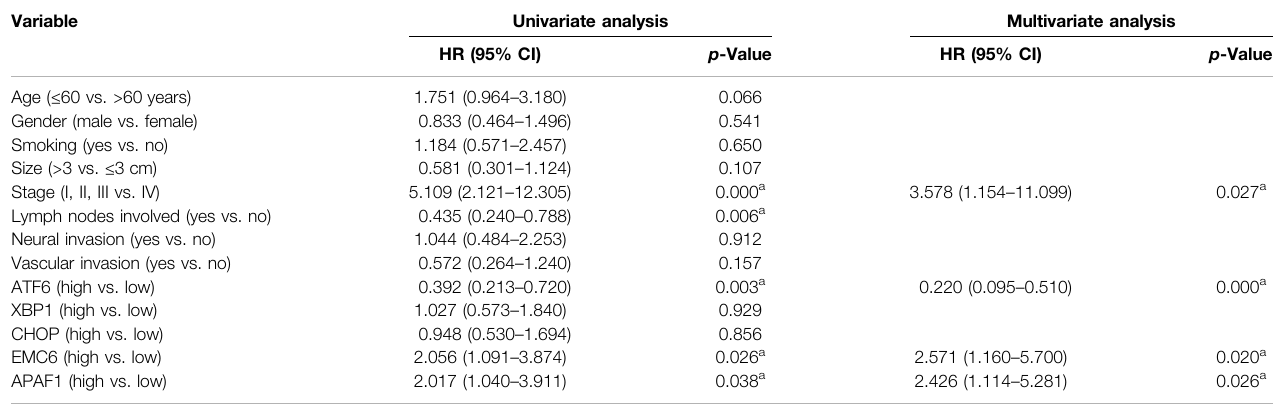
TABLE 2 | Univariate and multivariate Cox regression analysis for recurrence-free survival. Variable